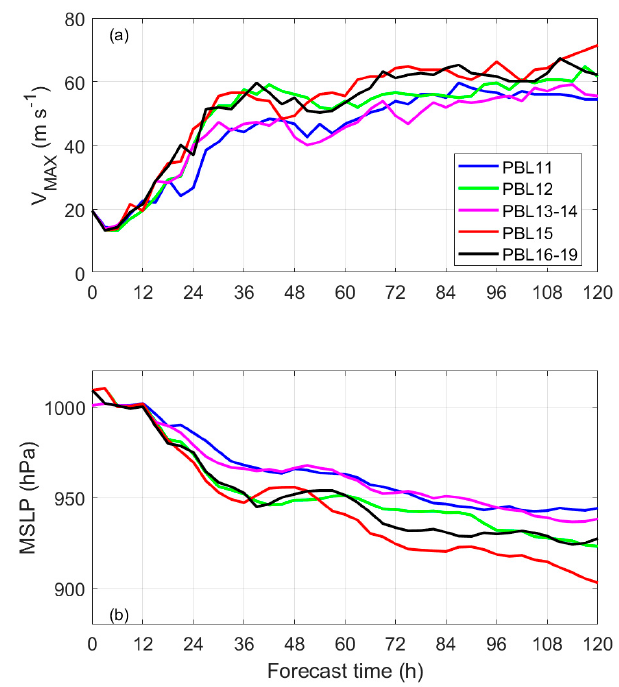
Figure 2. Time series of storm intensity in terms of ( a ) maximum surface wind speed ( V MAX ) and ( b ) minimum sea level pressure (MSLP) in the five idealized HWRF simulations with different PBL schemes.